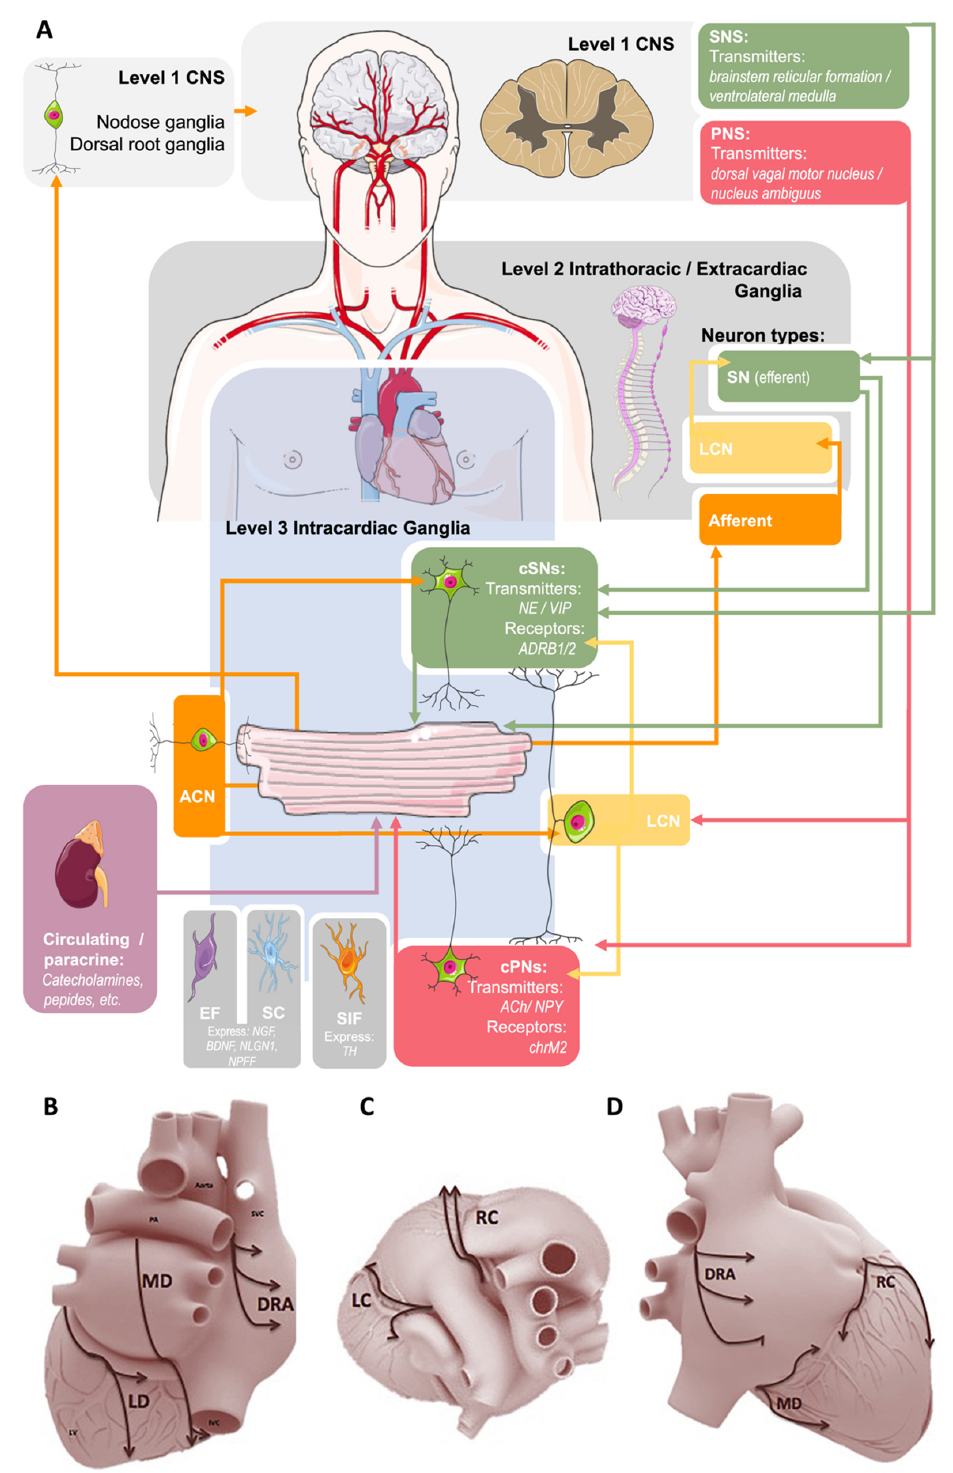
Figure 1. Summary of the current conceptual model of autonomic control of the heart. ( A ) : Sympathetic innervation (SN, green) originates from the central (Level 1) and intrathoracic (Level 2) levels and projects to cardiac sympathetic neurons (cSNs) within the intracardiac nervous system (IcNS, Level 3). Parasympathetic (PNS) innervation (red) comes from the central level via the vagus nerve to cardiac parasympathetic (cPNs) and local circuit (LCN) neurons within the IcNS. Sensory afferent neurons (orange) project to nodose and dorsal root ganglia, and afferent cardiac neurons (ACN) project